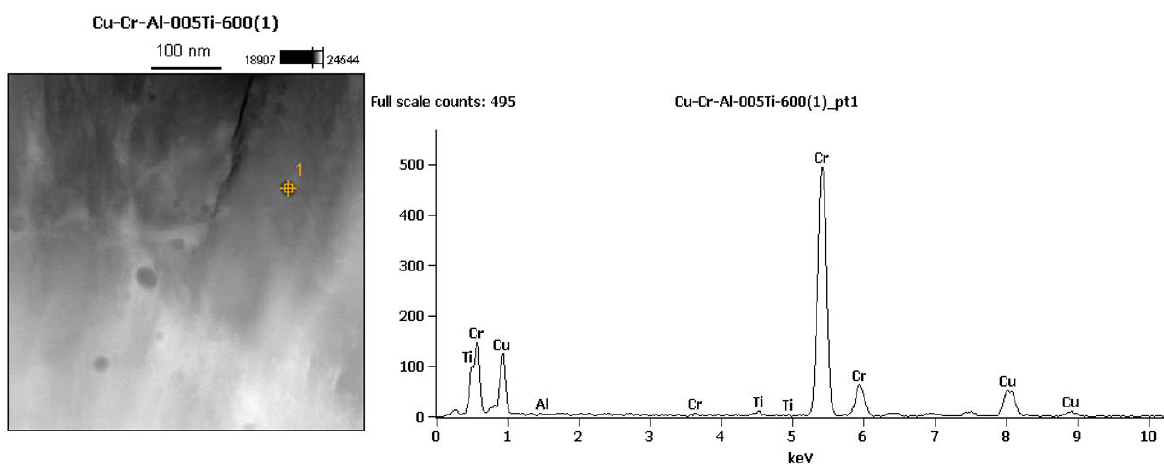
Figure 3. Observation and identification of precipitation of Cu-Cr alloys by TEM and EDS (the point indicating “1” means the point to be investigated by EDS).